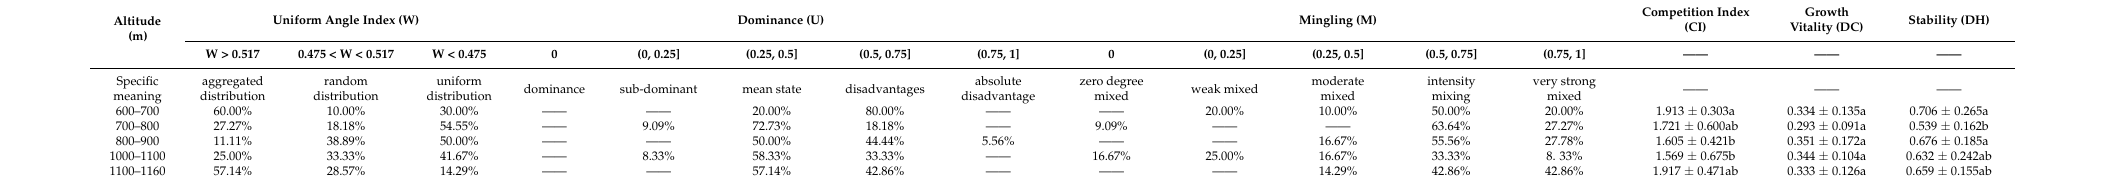
Table 6. Structural and non-structural parameters of plant communities at different altitude gradients.